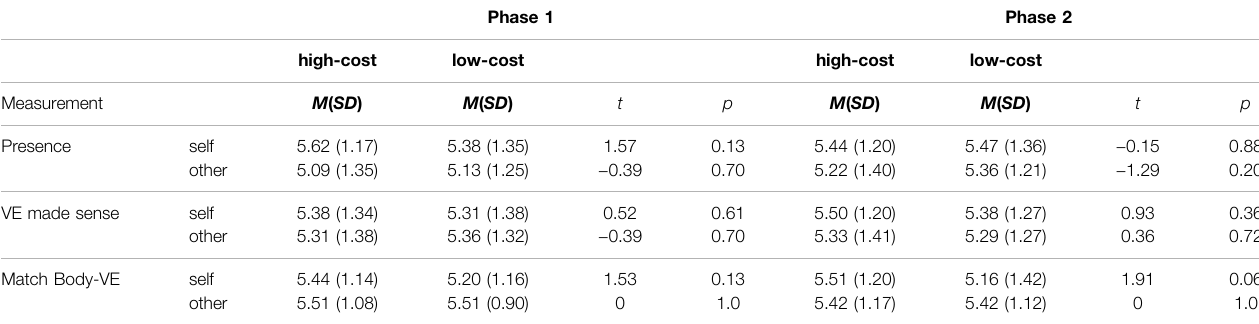
TABLE 4 | Means, standard deviations, and test statistics for the paired samples t-tests for the control measures presence, plausibility of the environment, and match ofthe virtual body to the virtual environment. For all t-tests: df (cid:2)